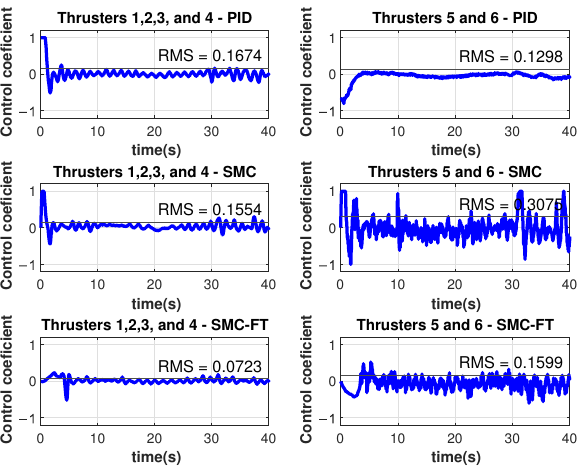
Figure 18. Control coefficients on the thrusters for the different control